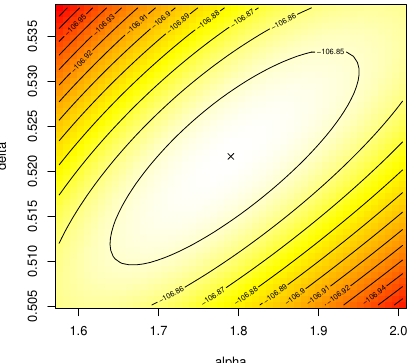
Figure 6. Contour plot of α and δ under electrical appliances data.